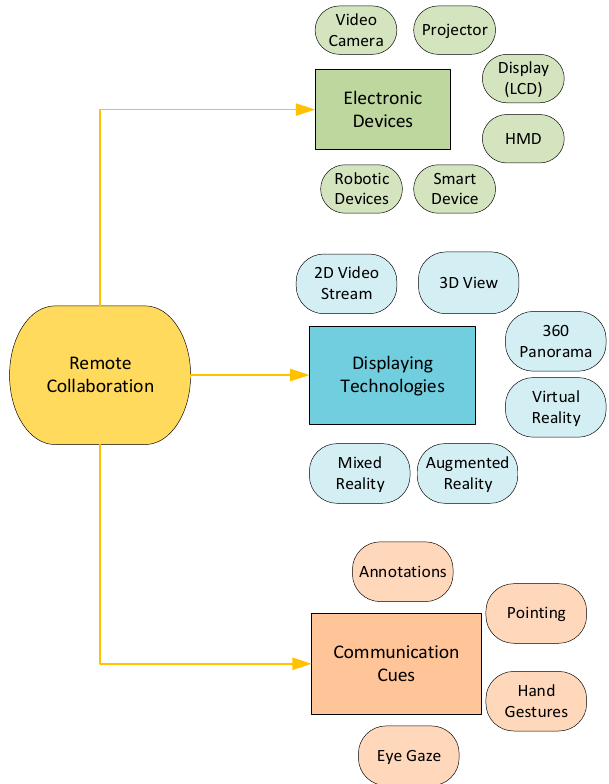
Figure 3. Plan of the review distributed across the three focus areas—electronic devices, display technologies, and communication cues—with the generalization of each topic into